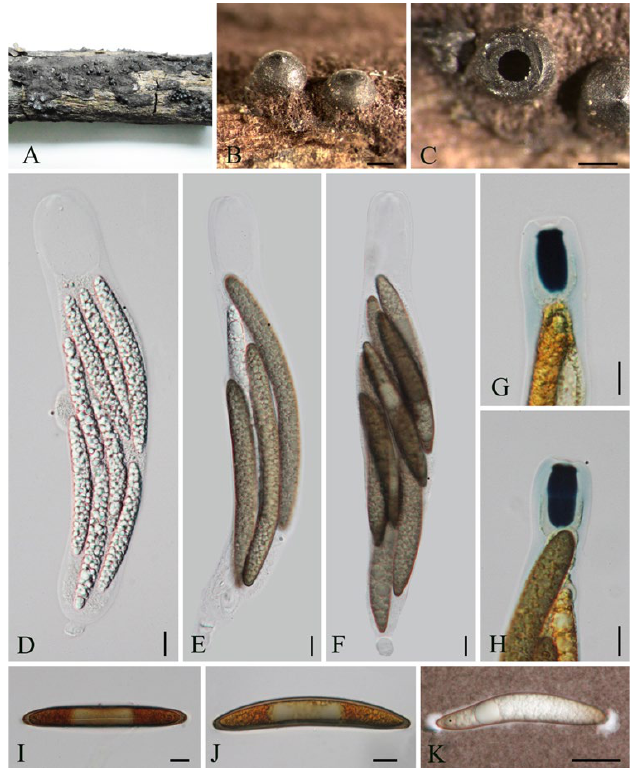
Figure 6. Rosellinia thailandica (MFLU12-2136, holotype). ( A , B ) Stromata of on the host; ( C ) Cross-section of a stroma; ( D ‒ F ) Asci; ( G , H ) Asci apical rings (stained in Melzer’s reagent); ( I – K ) Ascospore with a germ slit and end-sheaths; ( I , J stained in Melzer’s reagent; K , stained in ink). Bar: ( B , C ) = 500 μm, ( D – K ) = 10 μm.